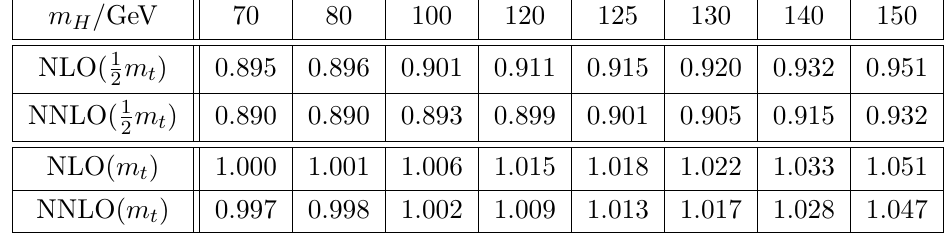
Table 2. Ratios Γ (N)NLO ( µ R ) / Γ LO ( µ R ) for µ R = m t / 2 or m t . Monte-Carlo statistical uncertainties at NNLO are small and not